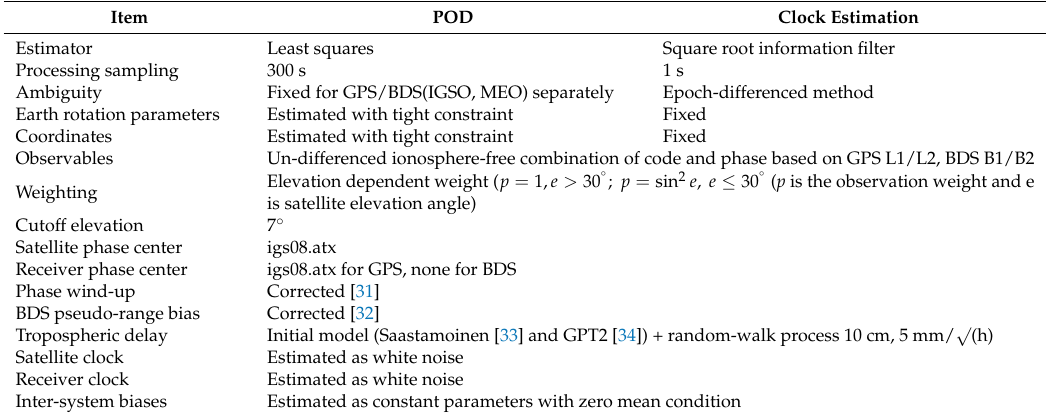
Table 1. Observation models involved in BDS/GPS POD and clock